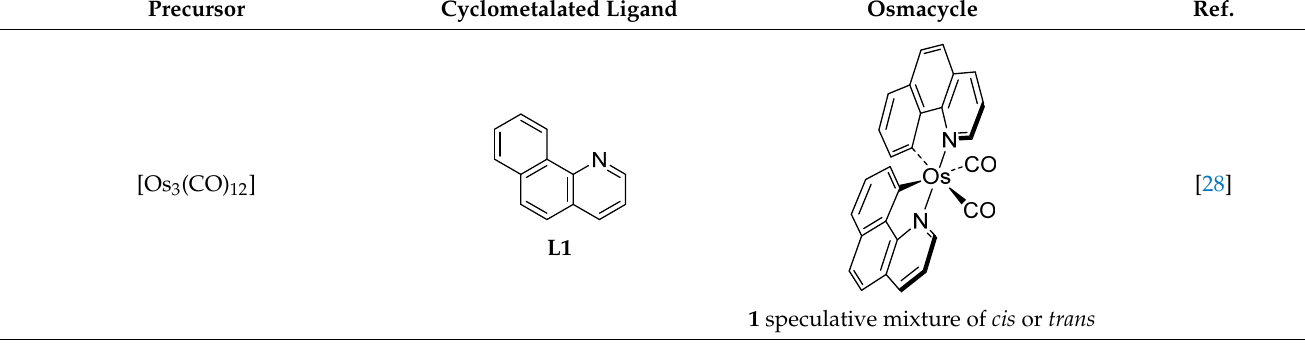
Table 1. First osmacycles prepared between 1973 and 1997.